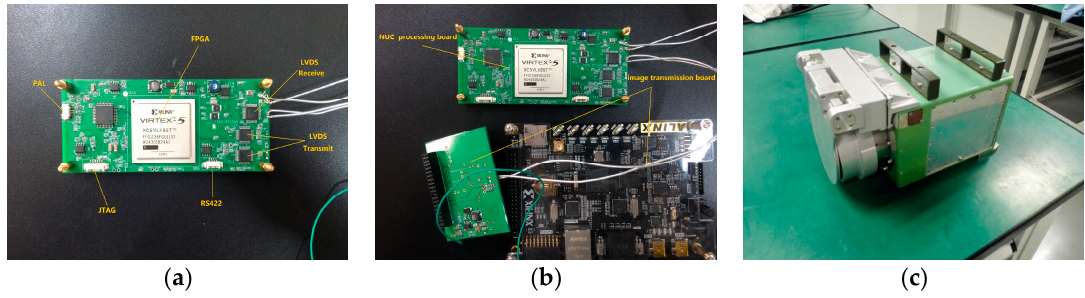
Figure 17. Photographs of the physical system. ( a ) FPGA processing board; ( b ) FPGA processing board and image storage board; and ( c ) the thermal imager equipped with the processing board.